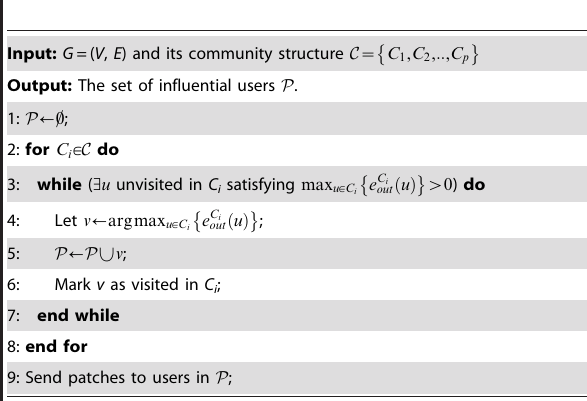
Table 6. Algorithm 6. Patch Distribution